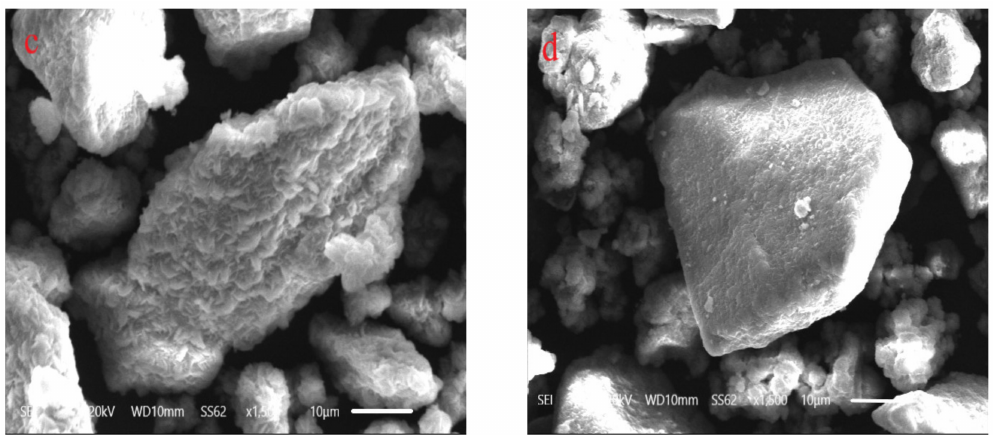
Figure 14. SEM micrographs of filtered samples: ( a ) pH = 2.00, leached for 8 days; ( b ) pH = 2.00, leached for 16 days; ( c ) pH = 3.00, leached for 8 days; ( d ) pH = 3.00, leached for 16 days.